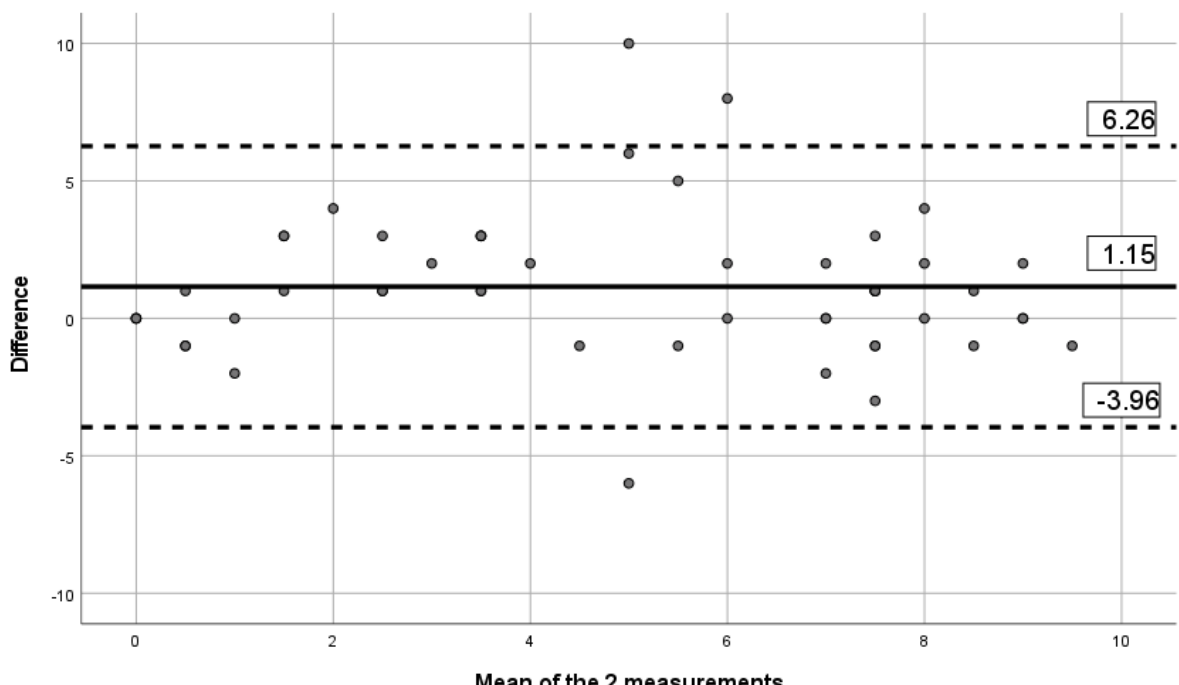
Figure 5. Bland-Altman limits for the issue of pain catastrophizing between the 2 assessments using the